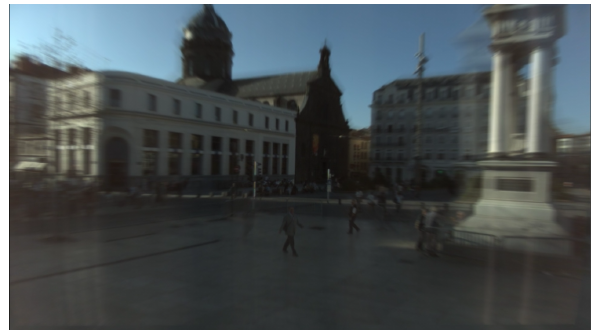
Figure 5: Uncertain scene bounded by a near paraboloid and a far plane.